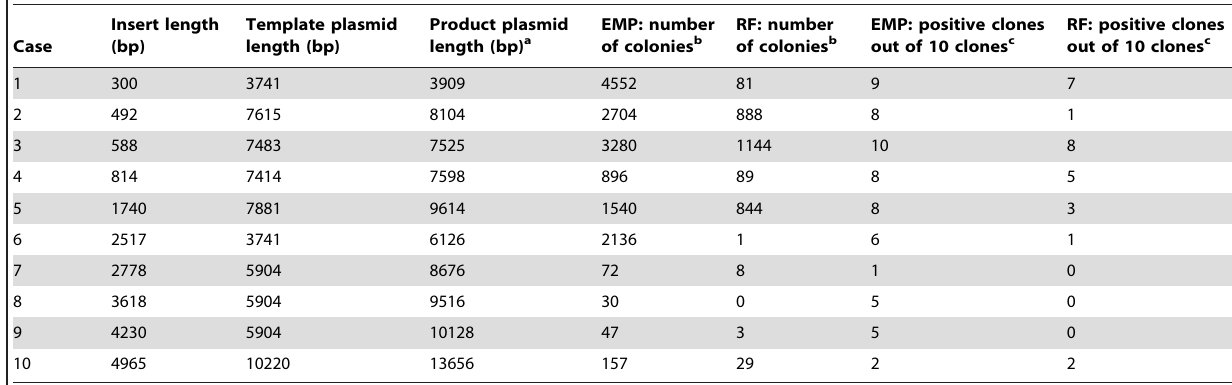
Table 1. Plasmid length, insert length and cloning efficiency of the 10 test cases.